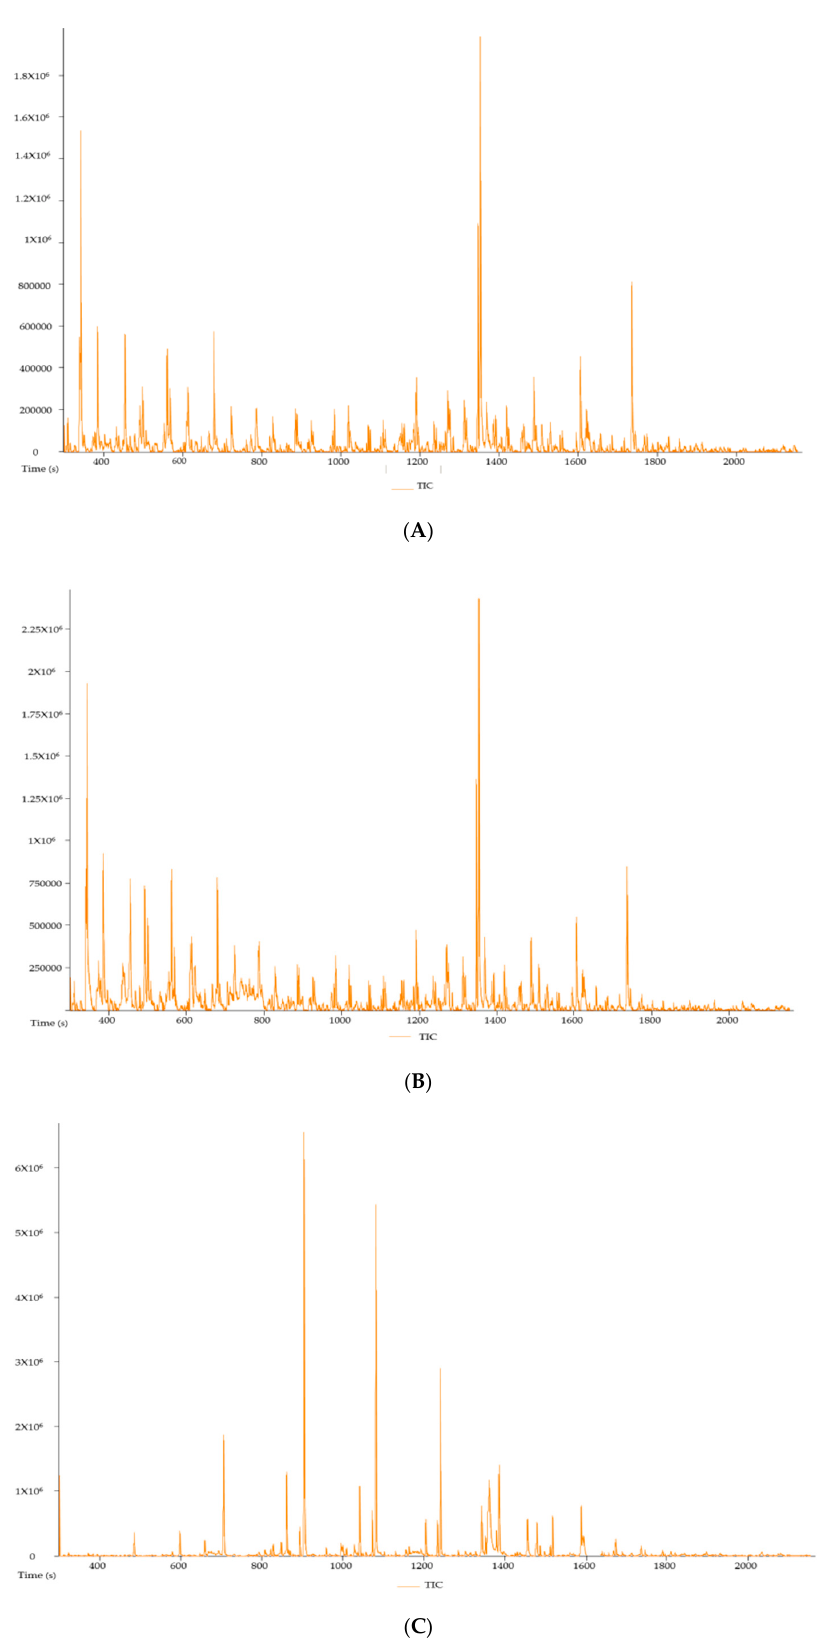
Figure 5. Gas chromatography-mass spectrometry (GCMS-MS) chromatogram of hot-water ( A ), cold-water ( B ) and 70% ethanol ( C ) extracts of P. natalensis